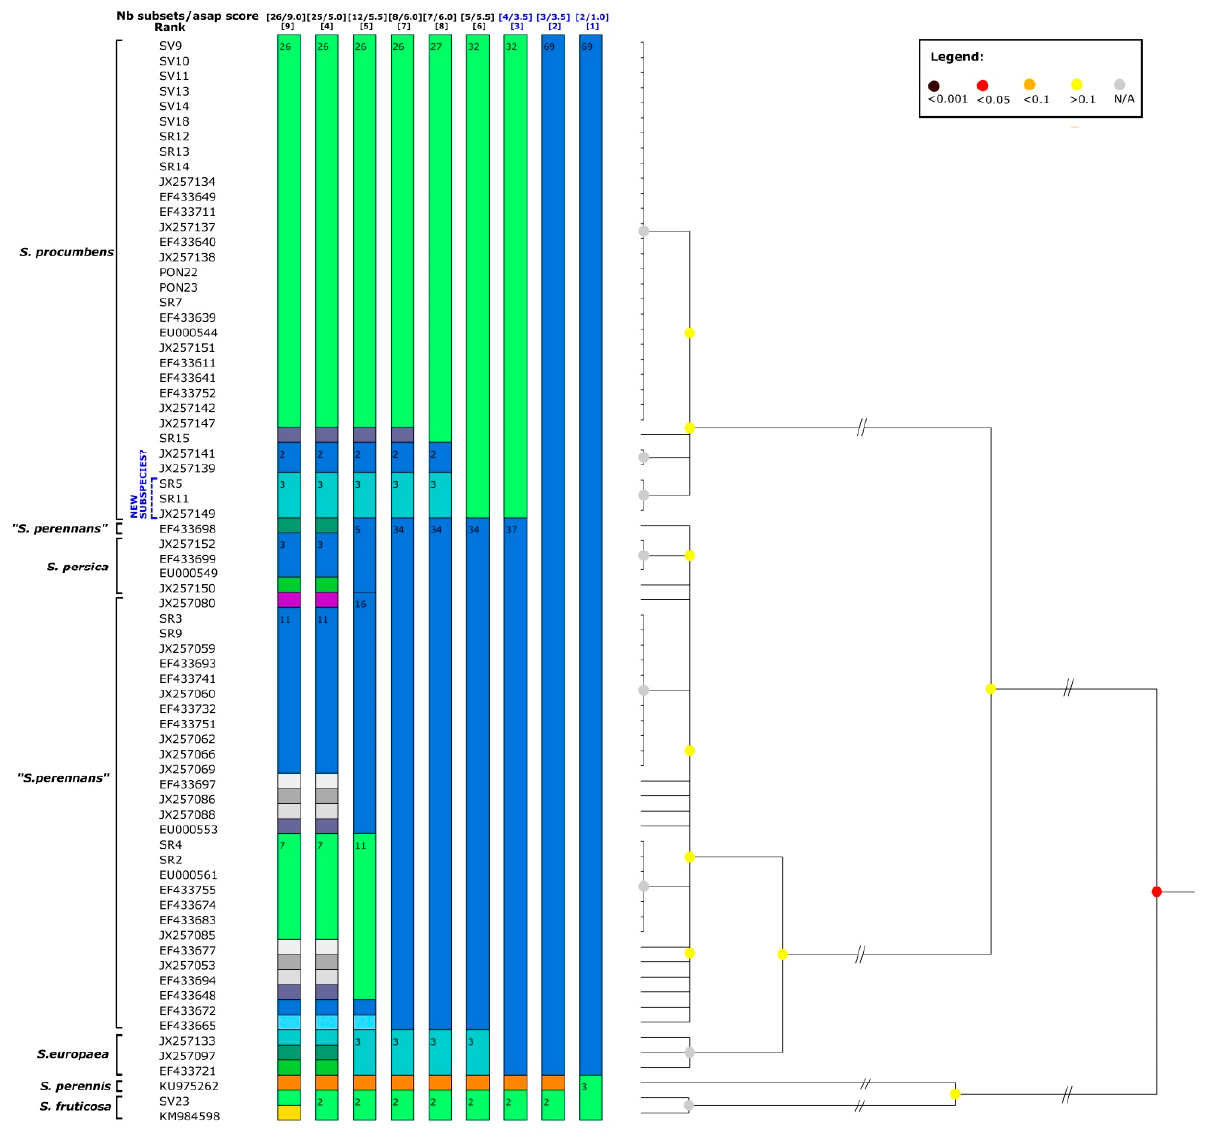
Figure 3. ASAP results for the ETS locus, with the species names reported on the left. In the first line, the blue colour highlights the partitions that are reported on the tree of Figure 2.